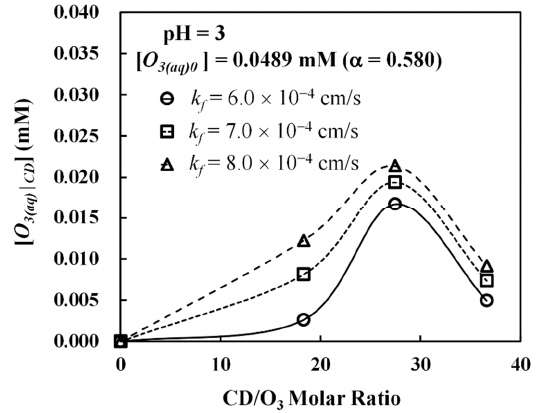
(cid:104) (cid:105) O 3 ( aq ) | CD ) as a function of